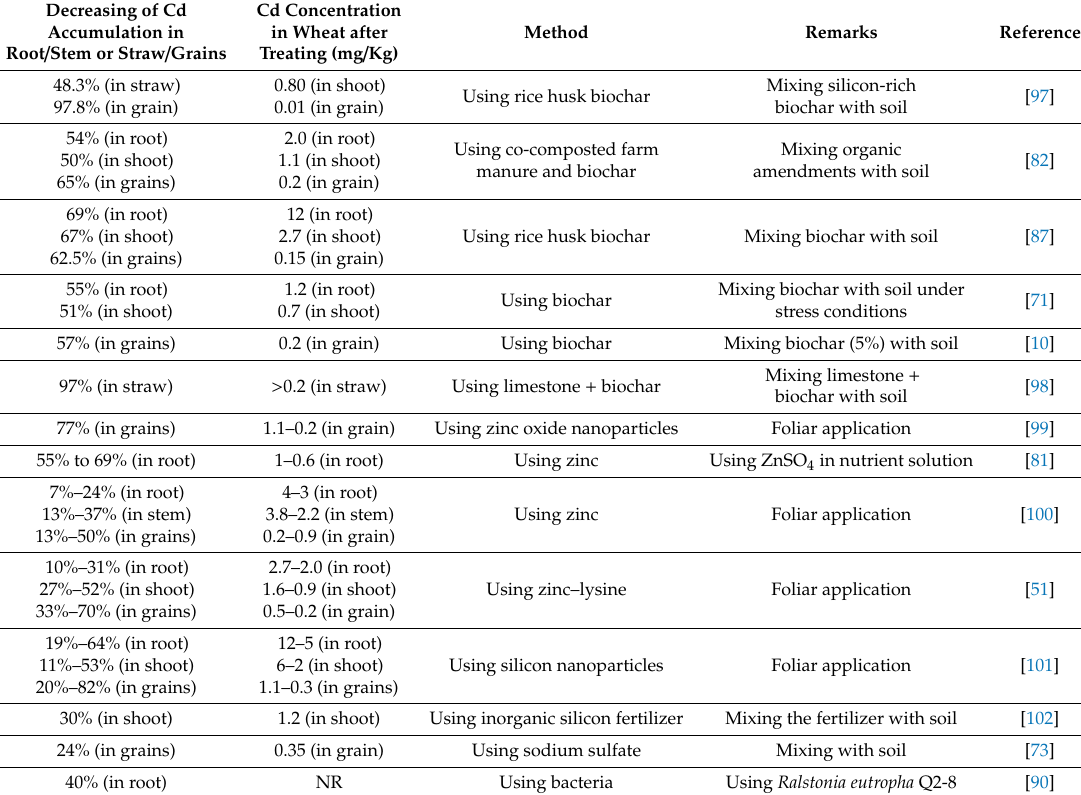
Table 3. Reported methods for decreasing the uptake of Cd by wheat